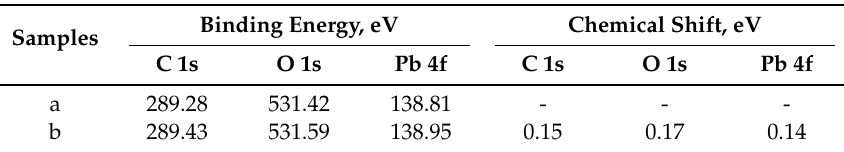
Table 3. Binding energy of each element from various cerussite samples treated with chloride ions: ( a ) before; ( b ) after.